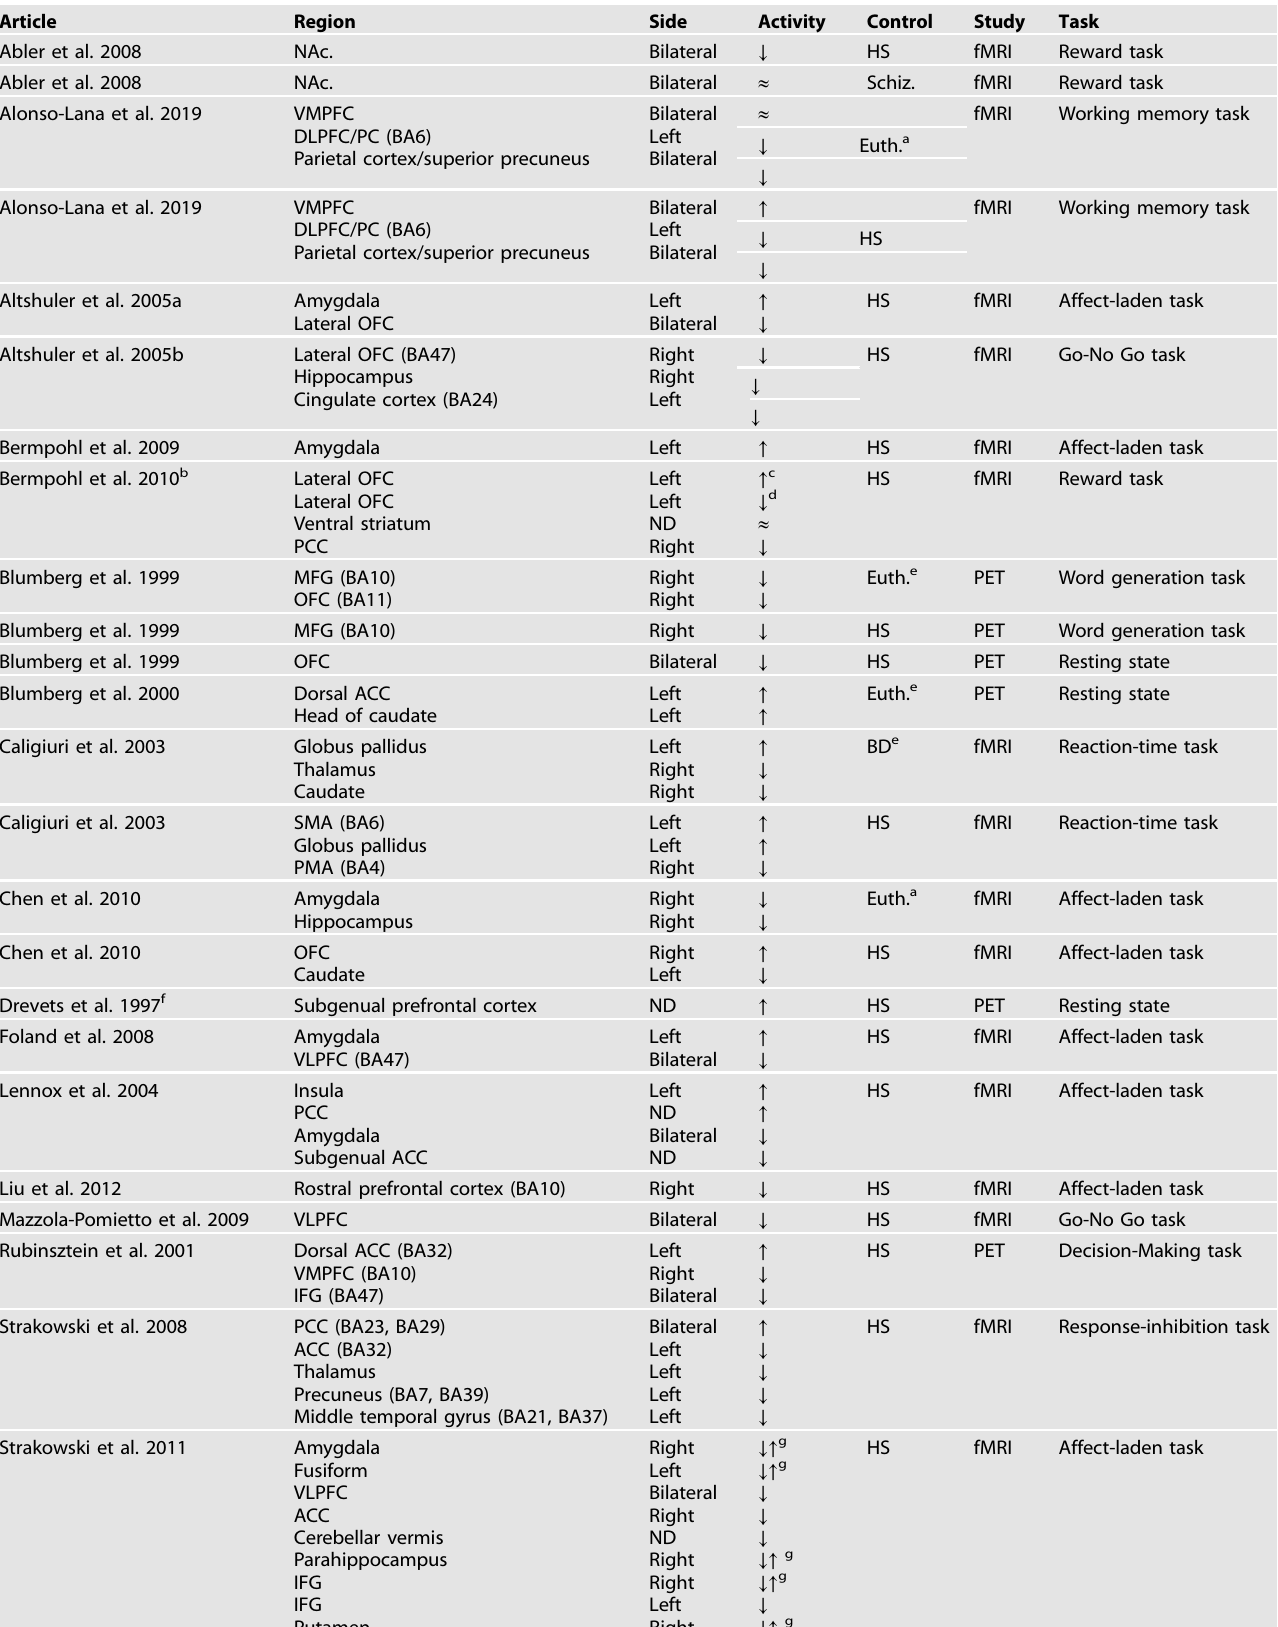
Table 1. Functional neuroimaging fi ndings during primary mania